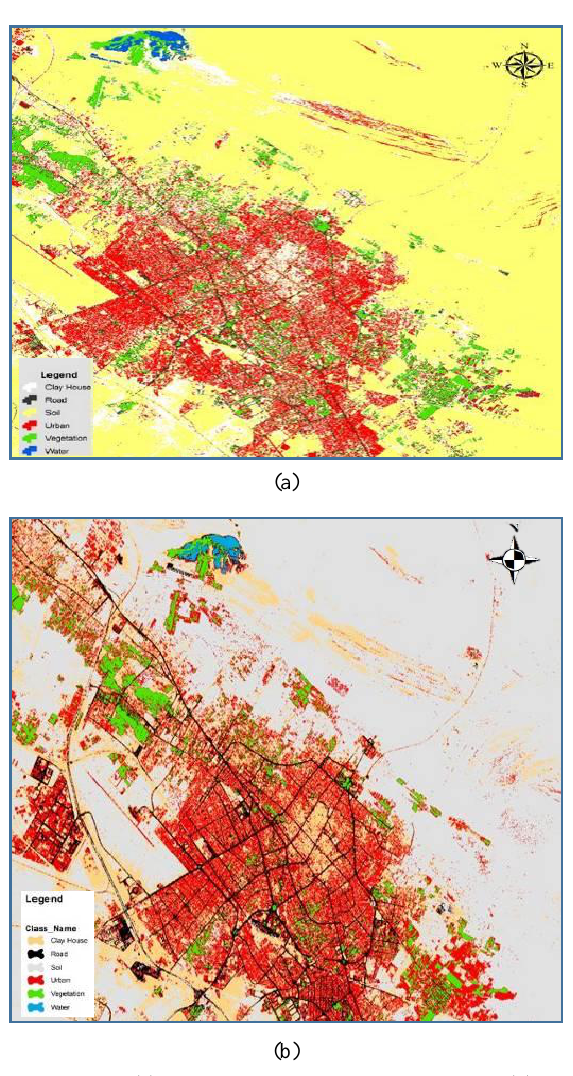
Figure 9. (a) Neural network Classification output, (b) Maximum likelihood Classification output.